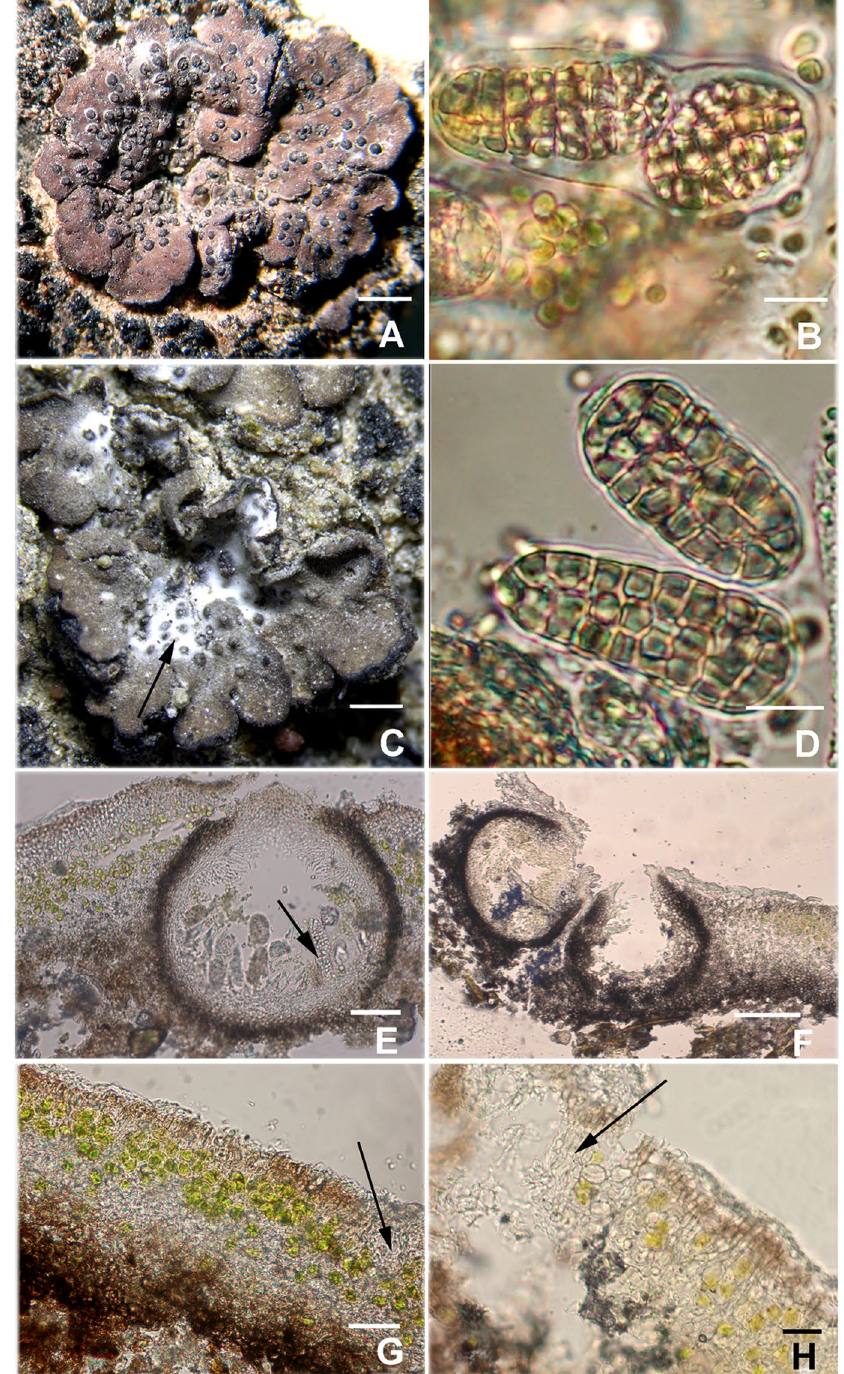
Figure 4. Endocarpon deserticola: ( A ) Upper surface of squamae with abundant perithecia (holotype, Z07090), scale bar = 1 mm; ( B ) an ascus containing two ascospores (paratype, SPT3–10), scale bar = 10 µ m. Endocarpon unifoliatum : ( C ) upper surface of unifoliate squama with slightly upturned margins (holotype, Z10020), the arrow pointing to white portion of thallus, scale bar = 0.5 mm; ( D ) muriform ascospores (paratype, SPT10063), scale bar = 10 µ m. ( E ) Anatomic structure of perithecia of Endocarpon deserticola (holotype, Z07090), the arrow pointing to ascospores, scale bar = 50 µ m. ( F ) Anatomic structure of perithecia of Endocarpon unifoliatum (holotype, Z10020), scale bar = 100 µ m; (G) Anatomic structure of thallus (holotype, Z10020), the arrow pointing to white part of upper cortex, scale bar = 50 µ m. ( H ) Partial magnification of anatomic structure of thallus (holotype, Z10020), the arrow pointing to white portion of the upper cortex and indicating less to absence of algal cells in this part, scale bar = 20 µ